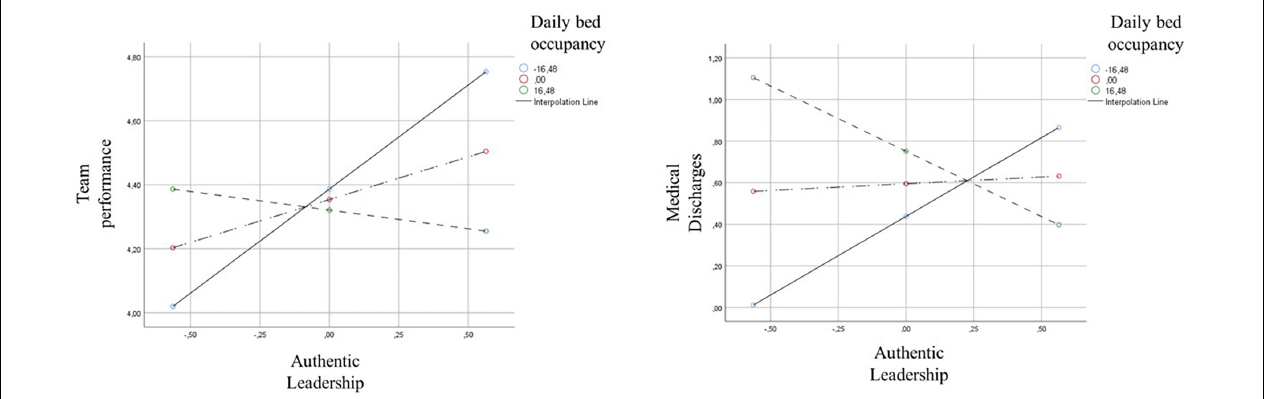
FIGURE 1 | Moderation graphs for the interaction between team leaders’ authentic leadership and daily bed occupancy, regressed on team performance (left graph) and medical discharges (right graph) .